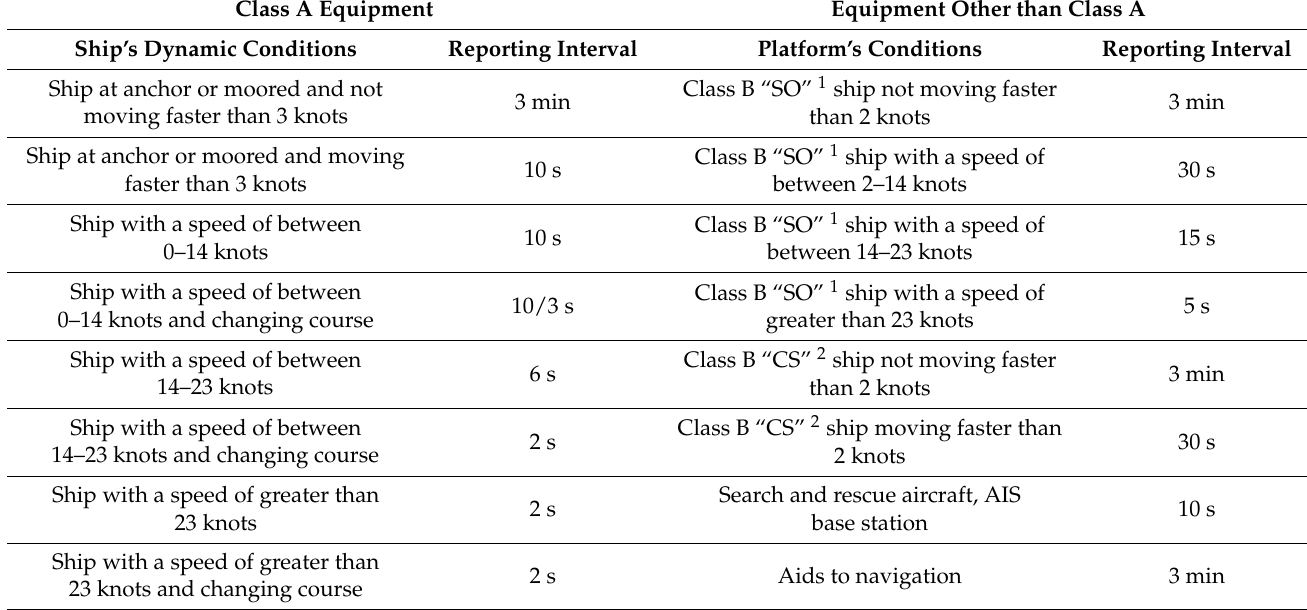
Table 1. Reporting interval requirements for AIS